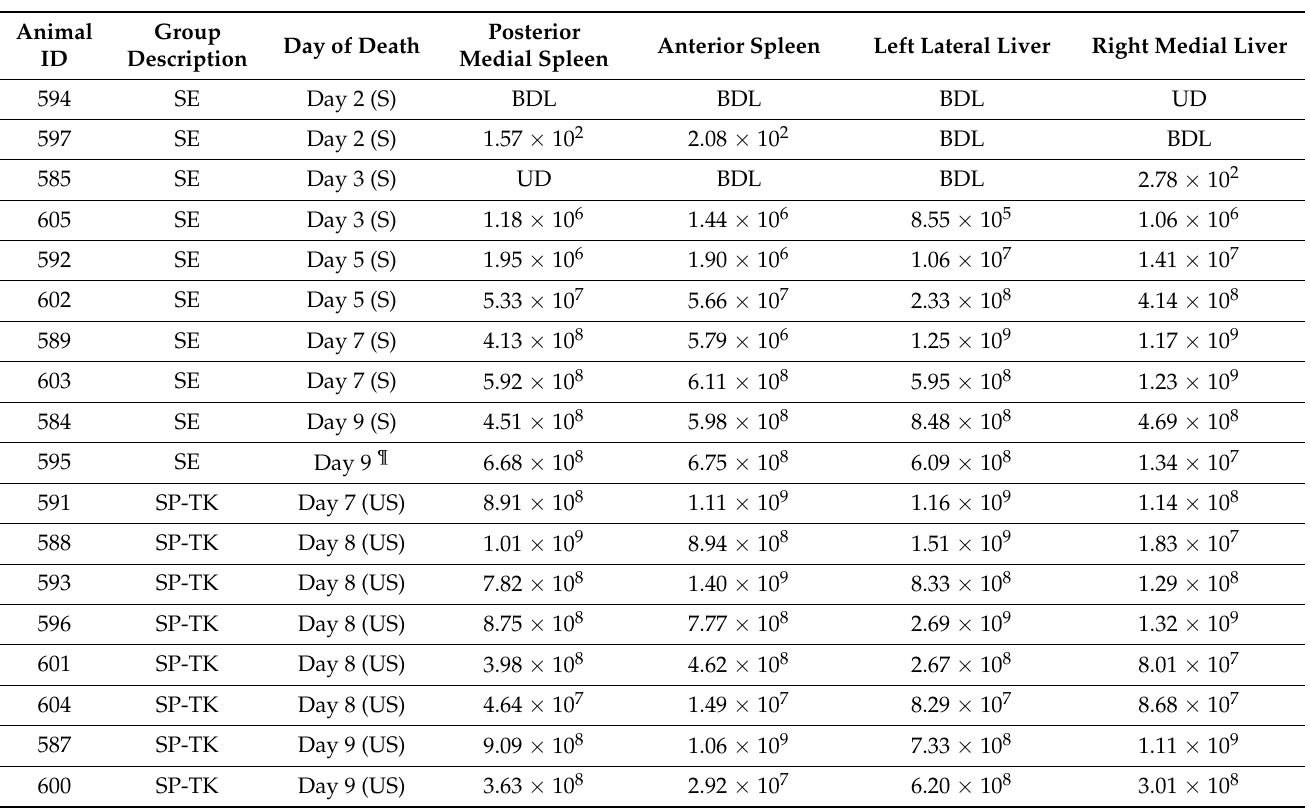
Table 4. Viral load in liver and spleen as determined by plaque assay (plaque-forming units/gram of